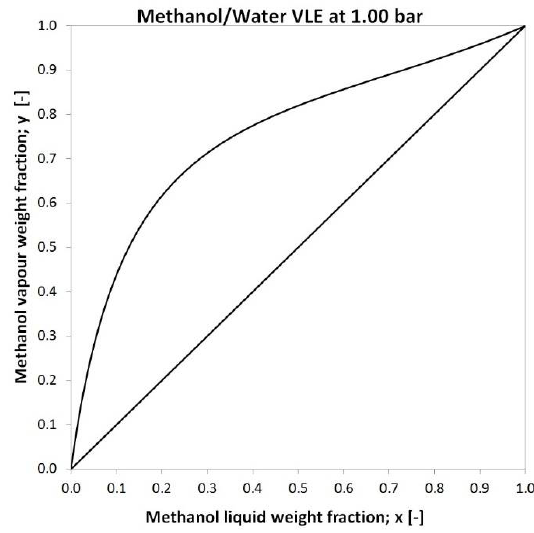
Figure 2. Methanol-water mixture vapour-liquid equilibrium diagram at 1 bar [72].